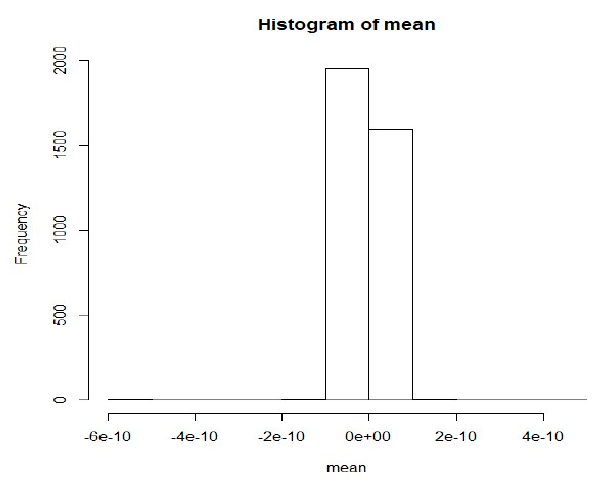
Figure 5. The mean of 3571 leukemia genes presented by histogram.